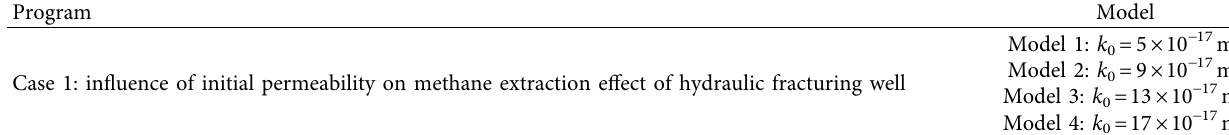
Table 2: Simulation strategy.